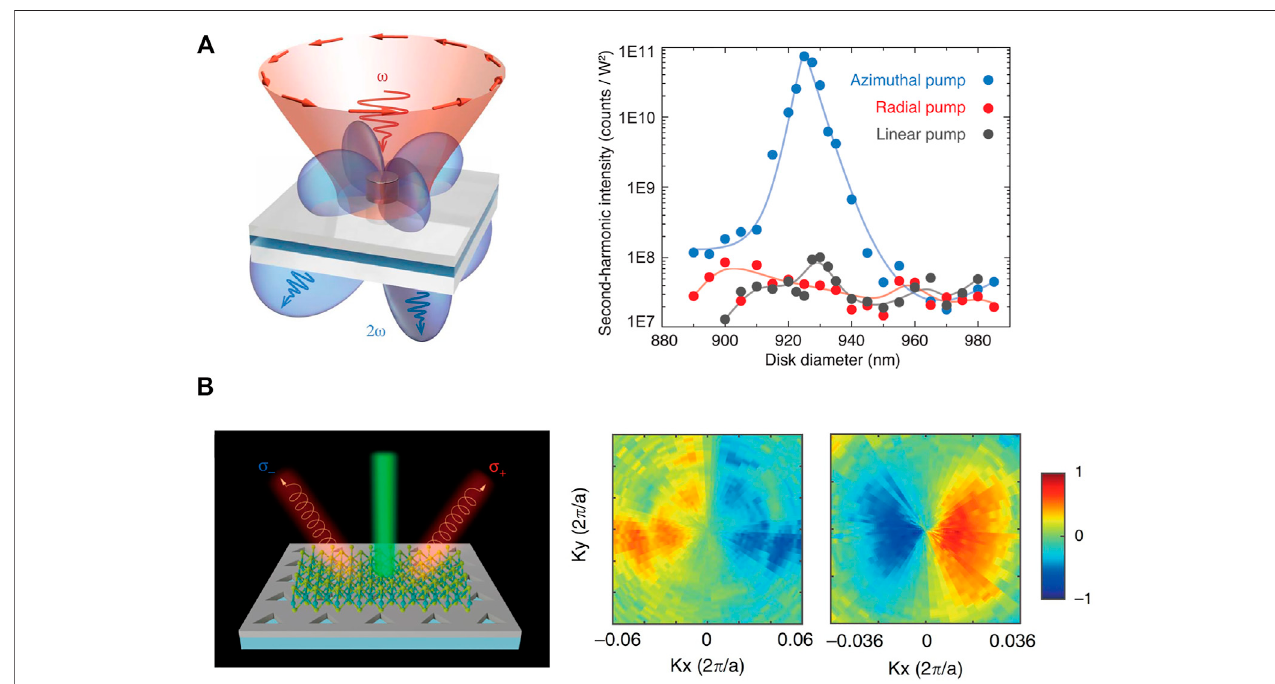
FIGURE 5 | Light-matter interaction enhancement and nonlinear optics. (A) SHG in an isolated antenna, the SH intensity vs nano-resonator diameter was measured at different pump polarizations [18],copyright AAAS. (B) Routing ofvalley photons with different chiralities by coupling to CPs, measured valley polarization in momentum space at 615 nm (left) and 628 nm (right) [129], copyright Springer Nature Ltd.